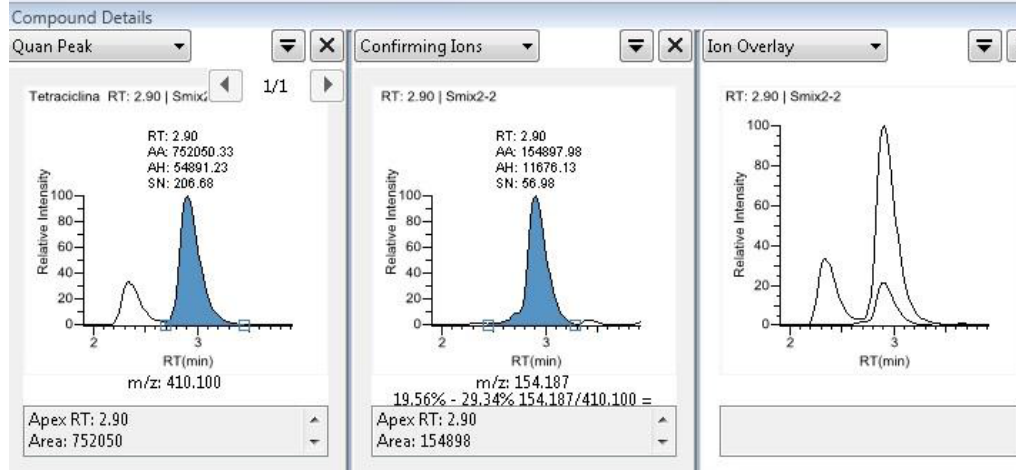
Figure 1. Chromatograms of a sample examined for TCs with relative m/z ratios. Table 2. Mean, range, and frequency of positive samples for tetracyclines (expressed in µg kg −1 ) of